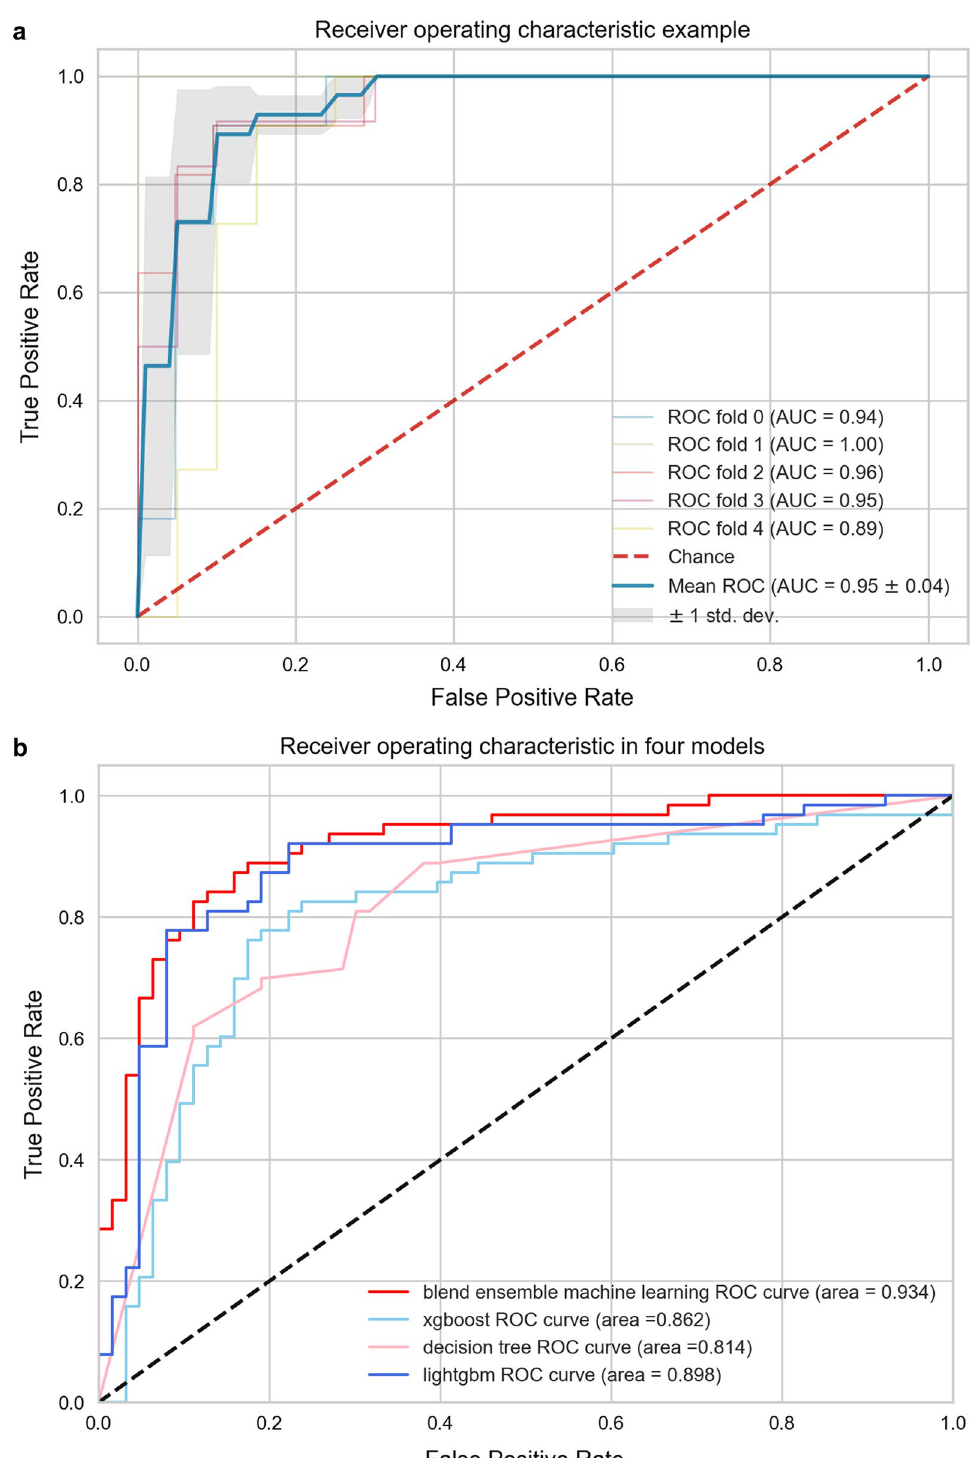
Fig. 4 The diagnostic efficacy of each model assessed by ROC curve. a The mean cross‑validated ROC of Blending ensemble model was 0.95. b All four models performed excellently in external validation